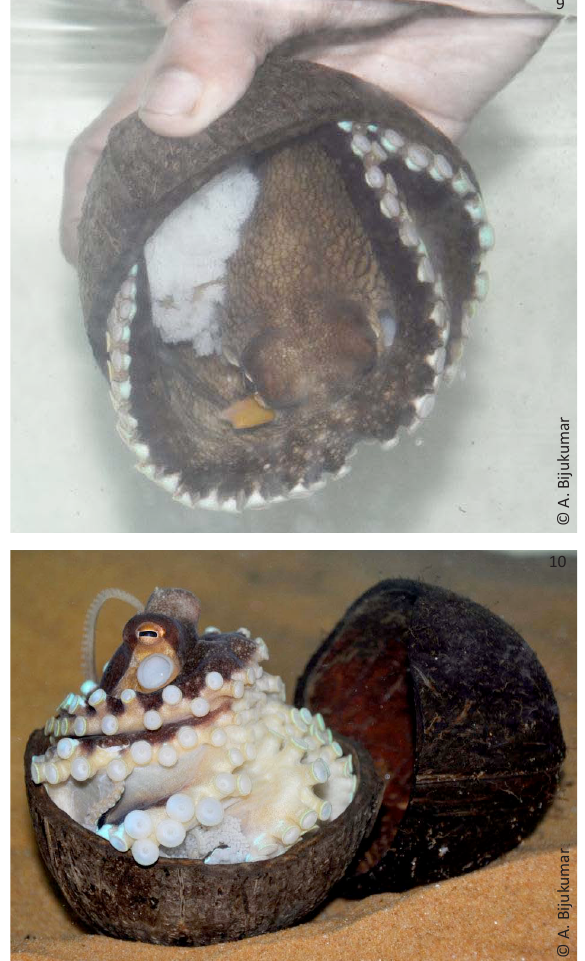
Images 9, 10. A. marginatus (female) with eggs laid inside the coconut shell